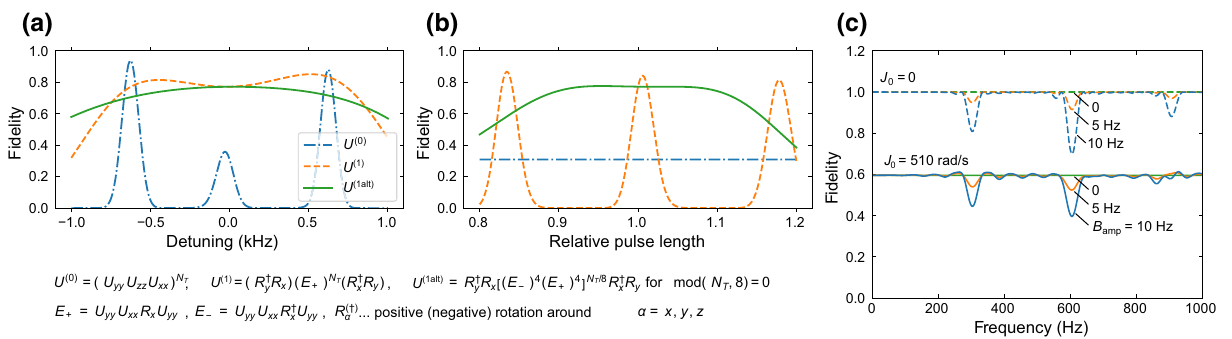
FIG. 6. Dynamical decoupling. The simulation is performed with 12 ions, a power-law approximation to the coupling, J 0 = 510 rad / s, α = 1.02, and 10 ms of evolution. The fidelity compares the simulated Trotter-approximated state with the exact ideal $ √ (cid:16) (cid:17) √ 2 . (a) The introduction of π/ 2 rotations into the Trotter sequence guards against detuning errors. The ρ ρ ρ state: Tr exact Trotter exact right-hand side (rhs) of Eq. (H5) defines the sequence U ( 0 ) , the rhs of Eq. (H22) defines U ( 1 ) , and the rhs of Eq. (H23) defines U ( 1alt ) . (b) Alternating the direction of the rotations guards against systematic rotation errors. (c) The response to oscillations of a time-varying magnetic field B = B amp cos ( 2 π ft ) ˆ z , wherein B amp ≥ 0 (15 ms evolution). The dynamically decoupled Trotter sequence U ( 1alt ) allows the fidelity to drop. The drops occur when the frequency of the field, f , is an integer multiple of f 1 = 1 can understand this behavior most simply when J 0 = 0 (top curves): the qubits do not interact, so each qubit remains in a superposition, the relative phase of which changes undesirably under B